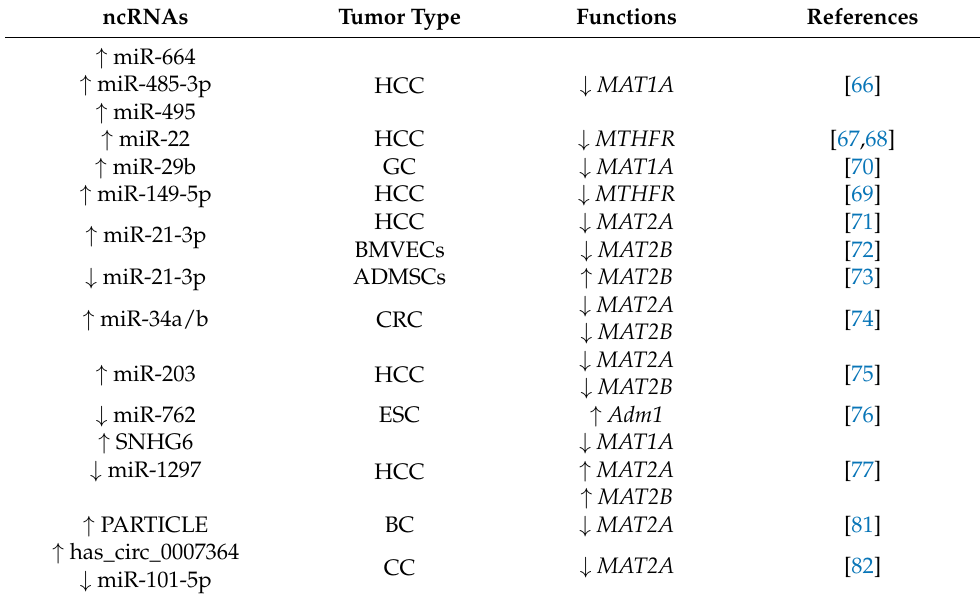
Table 1. Overview of ncRNA involved in modulation of AdoMet